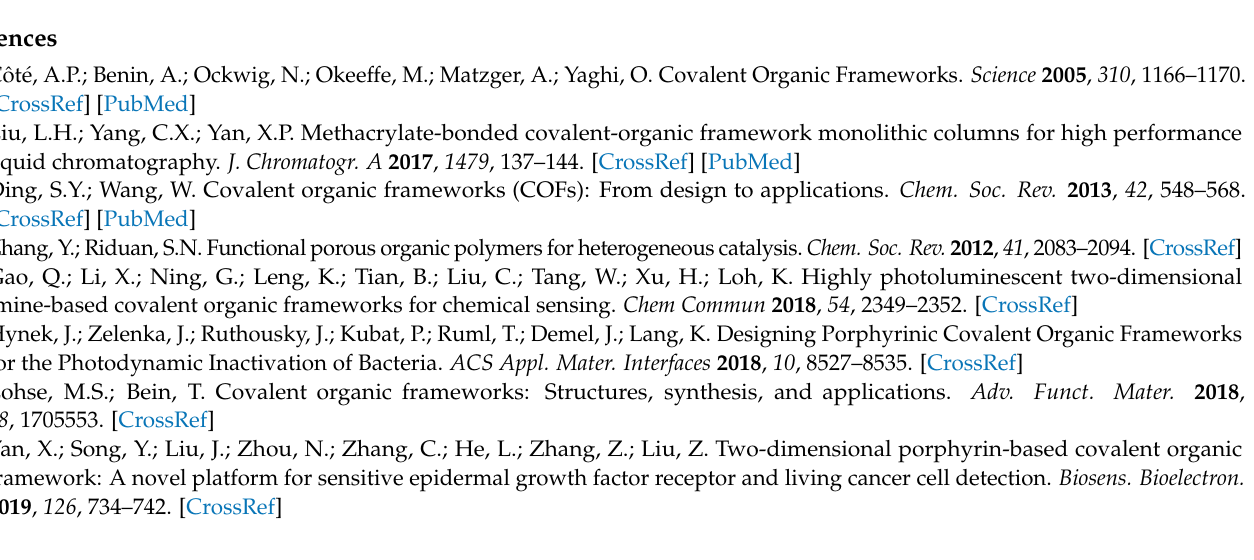
Figure S4: (a) UV-vis spectrum and (b) SDS-PAGE of practical analysis of magnetic 3D COF-GSH MIPs. Table S1: Optimization of amounts of TEOS and APTES in synthesis reaction of magnetic 3D COF-GSH